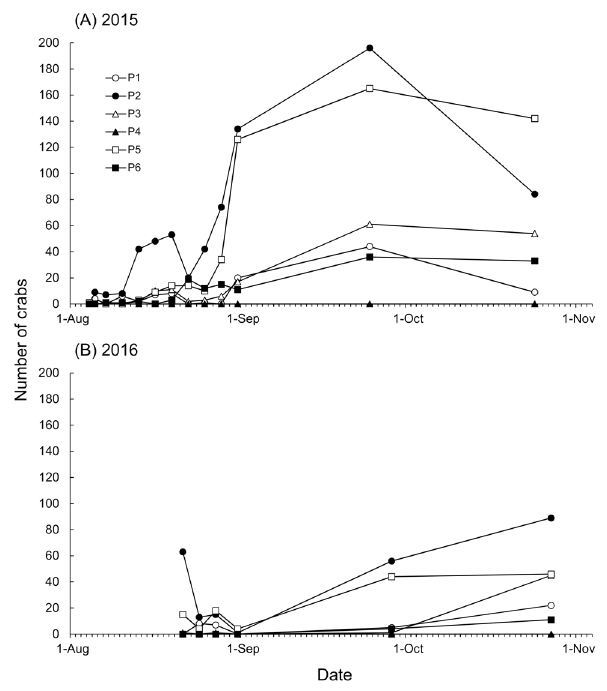
Figure 4. Number of early juveniles counted at each survey point in the 2015 (A) and 2016 (B)